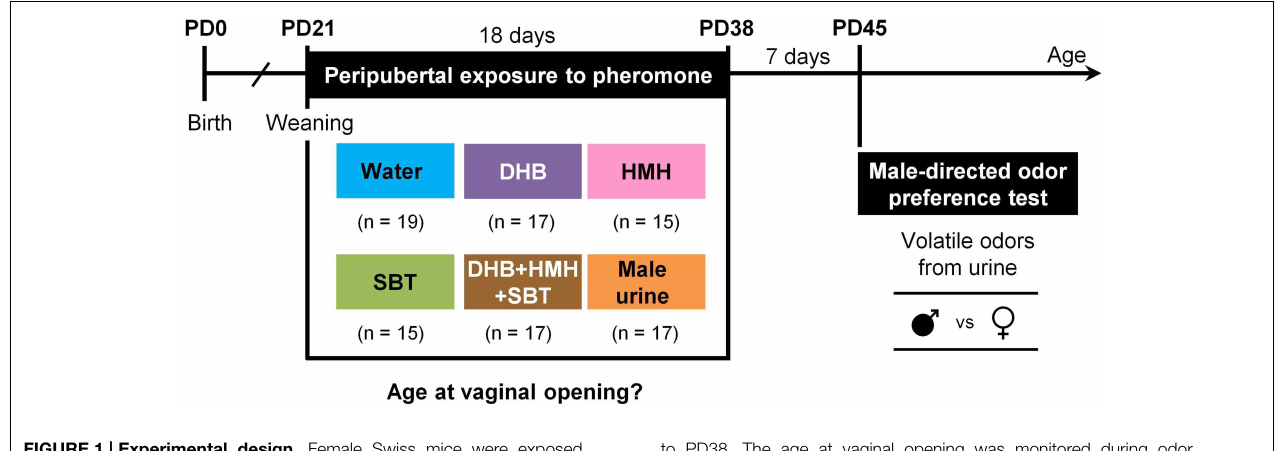
to PD38. The age at vaginal opening was monitored during odor exposure. At PD45, the time that females spent sniffing volatile odorants from male and female urine in a Y-maze apparatus was